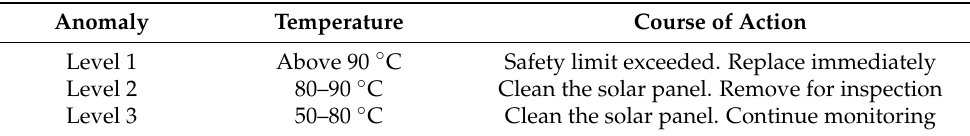
Table 5. The proposed course of action for each hotspot category.